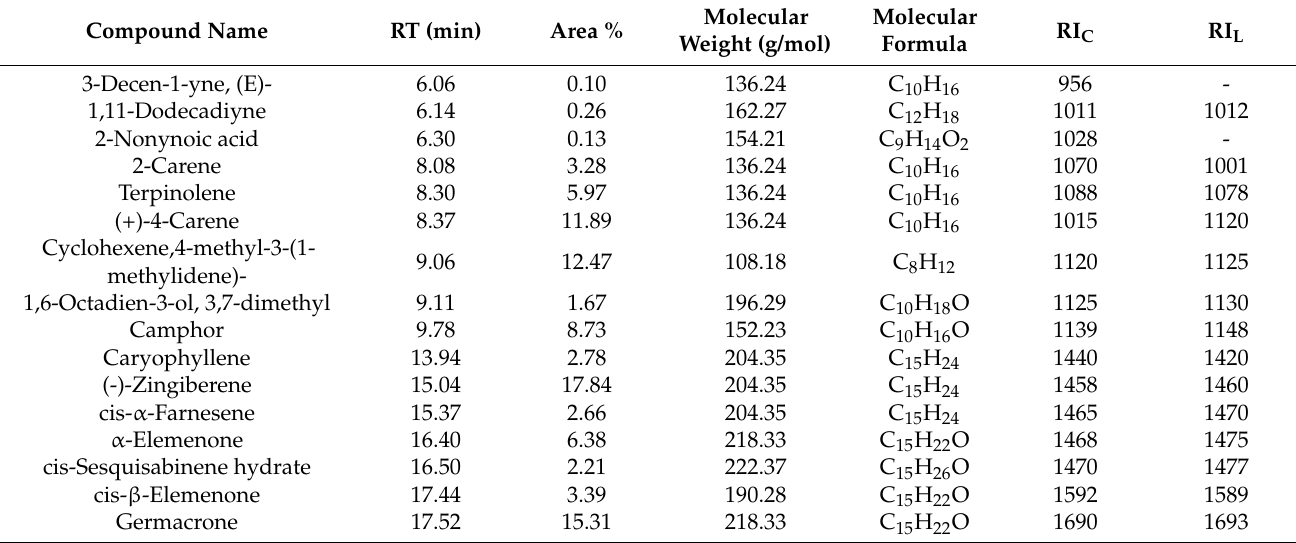
Table 1. Major compounds identified in CLO identified through